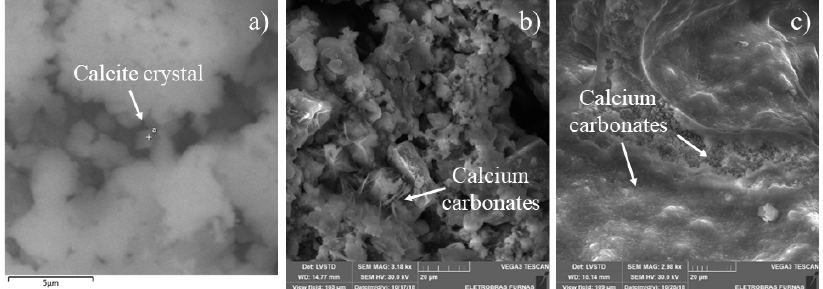
Figure 4. SEM micrographs with EDS analysis of treated soil–lime: ( a ) soil + 1% lime, 7 days; ( b ) soil + 2% lime, 7 days; ( c ) soil + 4% lime, 7 days; ( d ) soil + 1% lime, 56 days; ( e ) soil + 2% lime, 56 days; ( f ) soil + 4% lime, 56 days. Meaning of colours: green = aluminium; blue = calcium; red = silicon; yellow = iron; white = no data.